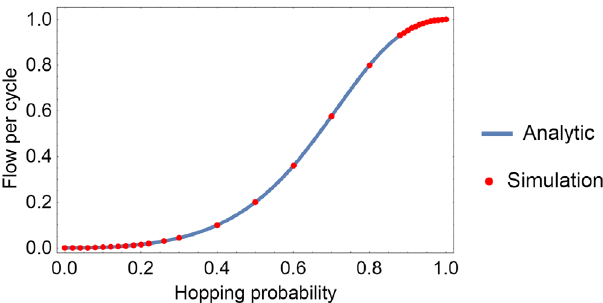
FIG. 7. Initial particle density chosen for the flow analysis. All sites below the line y ¼ l 1 are filled with particles (shown in blue). All sites above y ¼ l 2 are empty. The probability of finding a particle at sites in between y ¼ l 1 and l 2 is left arbitrary as the charge density in this region will not affect the